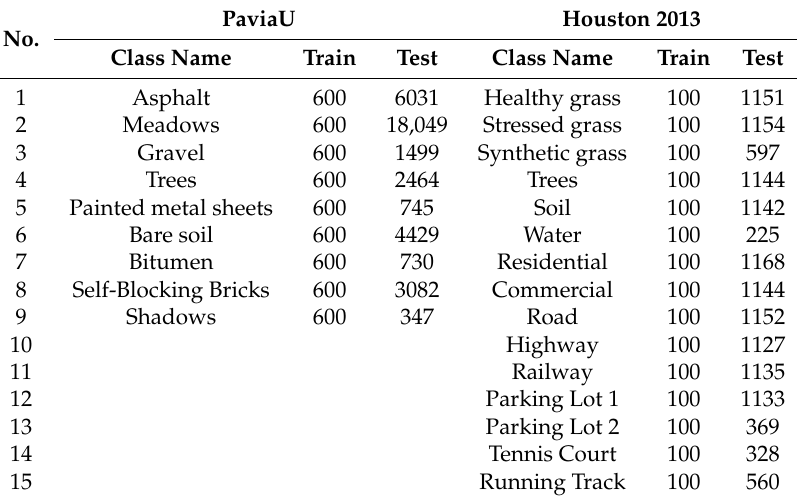
Figure 9. Houston 2013 scene: ( a ) true-color composite image; ( b ) ground truth. Table 5. The number of training and test samples for PaviaU and Houston 2013